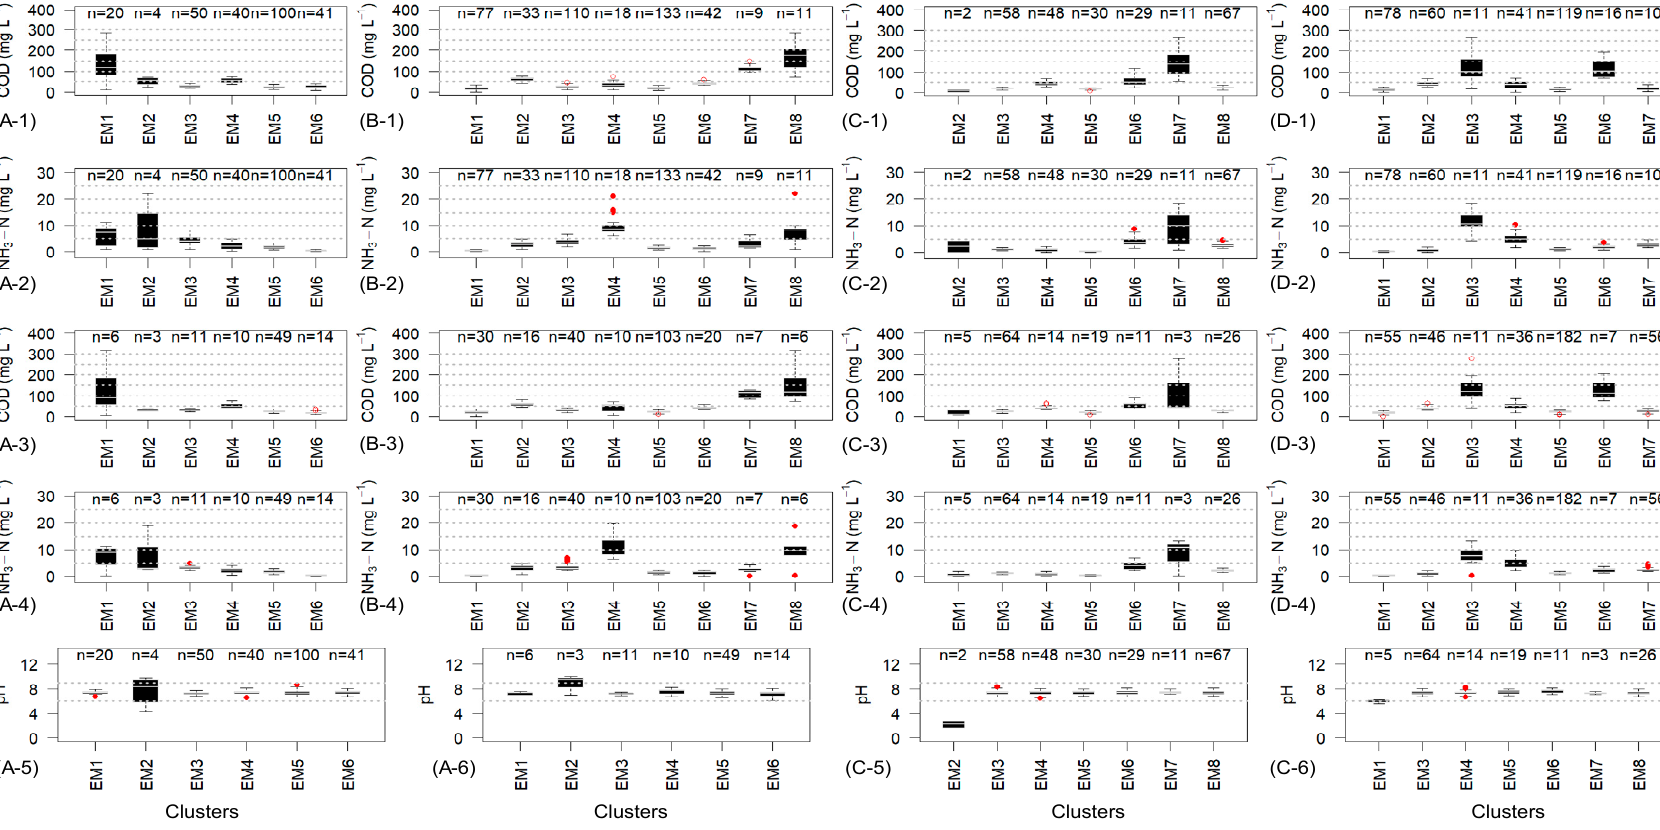
Figure 6. Yearly mean concentrations of COD, NH 3 -N, and pH vs. EM classifications of the YRB sewage outlets in the HPZ (heavily polluted zone) (sewage outlets in the PAM2 cluster by the PAM clustering: A-1, A-2, A-5, B-1, B-2, C-1, C-2, C-5, D-1, and D-2) and the UPZ (unpolluted zone) (sewage outlets in the PAM3 cluster by the PAM clustering: A-3, A-4, A-6, B-3, B-4, C-3, C-4, C-6, D-3, and D-4) using the EM clustering from 2016 and 2017. (A and B: the classifications of sewage outlets using the EM_A and EM_B methods in Table S3 for 2016; C and D: the classifications of sewage outlets using the EM_C and EM_D methods in Table S3 for 2017; n represents the number of wastewater outlets.).